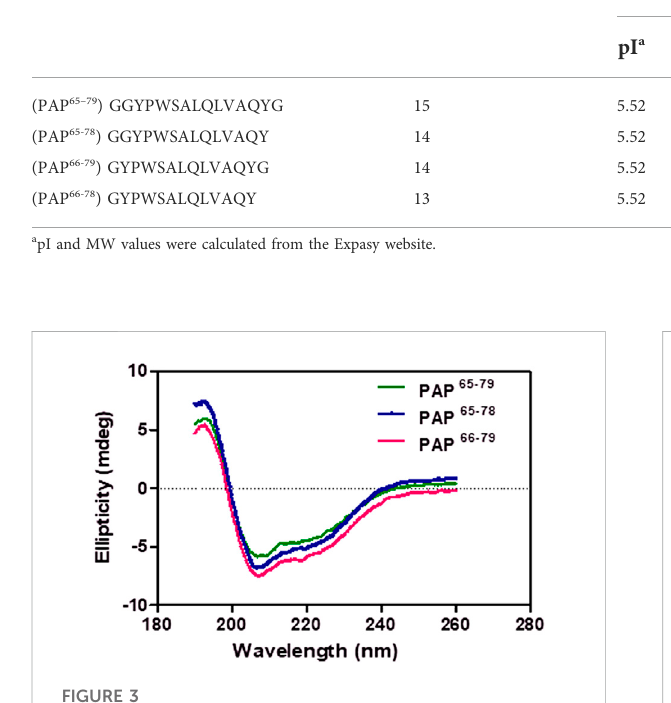
TABLE 1 List of the selected peptide segments as a template. Sequence